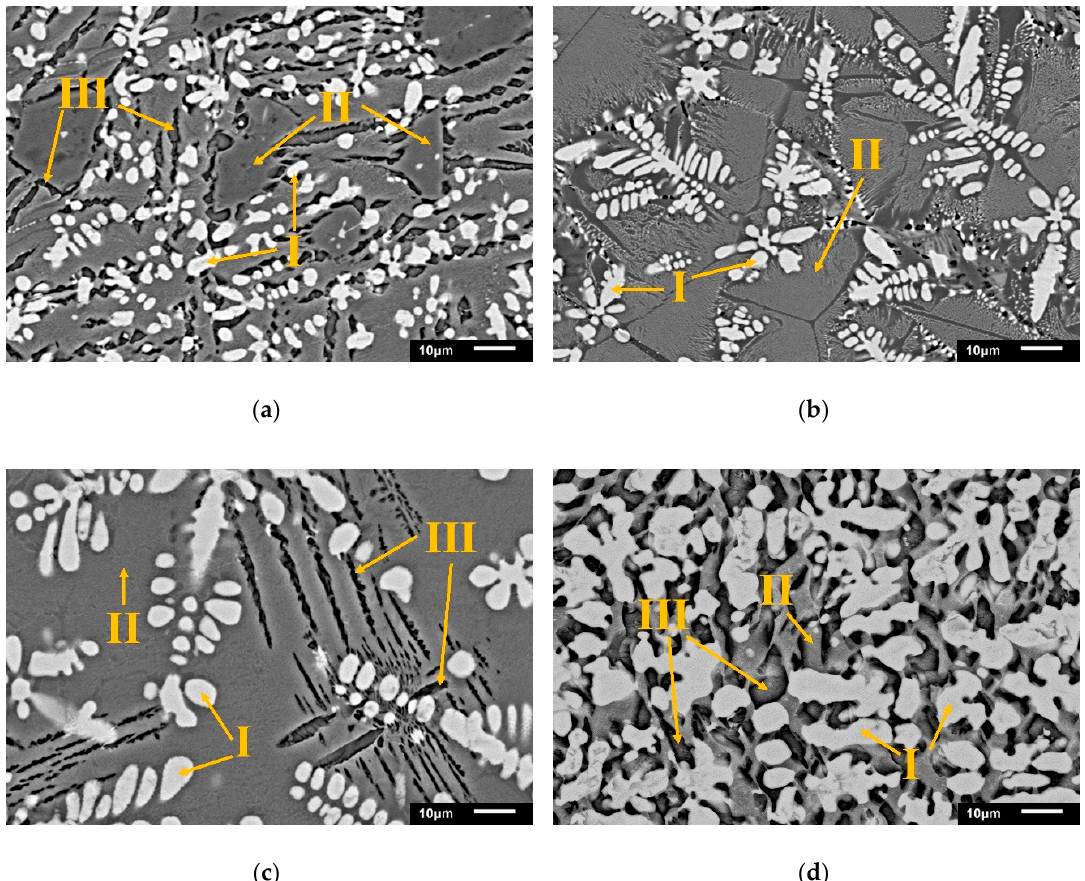
Figure 4. SEM-BEI of modified oxidizing slags after dephosphorization ( a ) S1; ( b ) S2; ( c ) S3; and the control group from a steel plant ( d ) EAFS (Phase I = FeO; Phase II = matrix; Phase III = C 2 S). Table 4. Chemical composition of each phase shown by SEM-EDS. Chemical Composition, Sample Phase